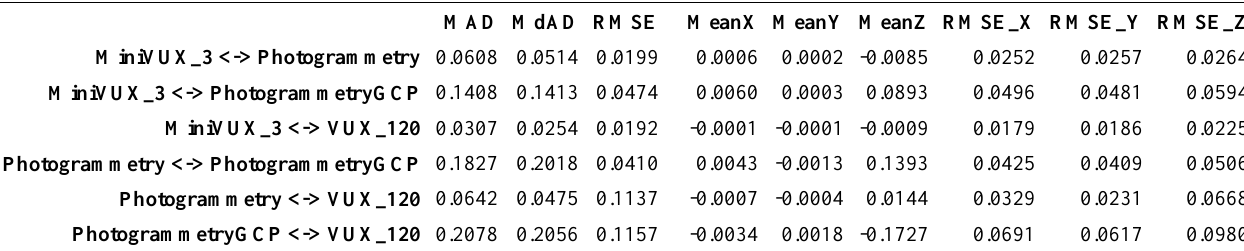
Table 2. Values of difference metrics over the eleven subsets.